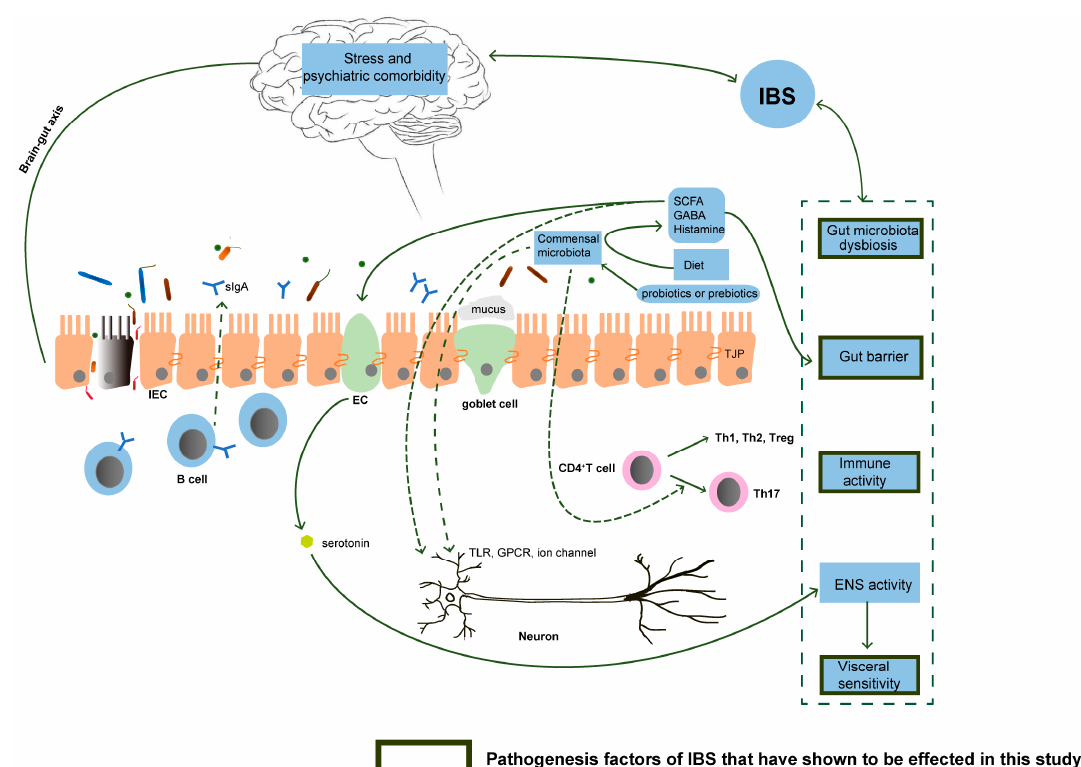
Figure 9. The pathogenesis factors related to irritable bowel syndrome (IBS) that can be affected by PB and PB/ProBio. The gut microbiota dysbiosis was improved by PB and PB/ProBio dramatically. Probiotics have been shown in many experimental models to stimulate regulatory T cells. A variety of prebiotics and probiotics are known to decrease immune-mediated activation in IBS [70,81]. PB and PB/ProBio exerted anti-inflammatory effect both in vitro and in vivo. Many available probiotics can reinforce the intestinal barrier function via enhance the expression of tight junction proteins, promote mucus secretion and host cell antimicrobial peptides, and directly release antimicrobial factors [82]. PB and PB/ProBio are shown to increase tight junction protein expression in this study. Enteric neurones express Toll-like receptors displaying sensitivity to microbial metabolites, and thus the enteric nervous system (ENS) has the capacity to respond to microbes [83]. SCFAs, the metabolites of normal microbiota, are able to stimulate sympathetic nervous system and mucosal serotonin release. Microbiota can influence ENS activity by producing molecules that can act as local neurotransmitters, such as GABA and histamine and by generating a biologically active form of catecholamines in the lumen of the gut [84]. The activation of ENS is responsible for visceral hypersensitivity, which can be suppressed by PB and PB/ProBio. Abbreviations: SCFA, short chain fatty acid; EC, enterochromaffin cells; IEC, intestinal epithelial cells; TJP, tight junction protein; GABA, gamma amino butyric acid;